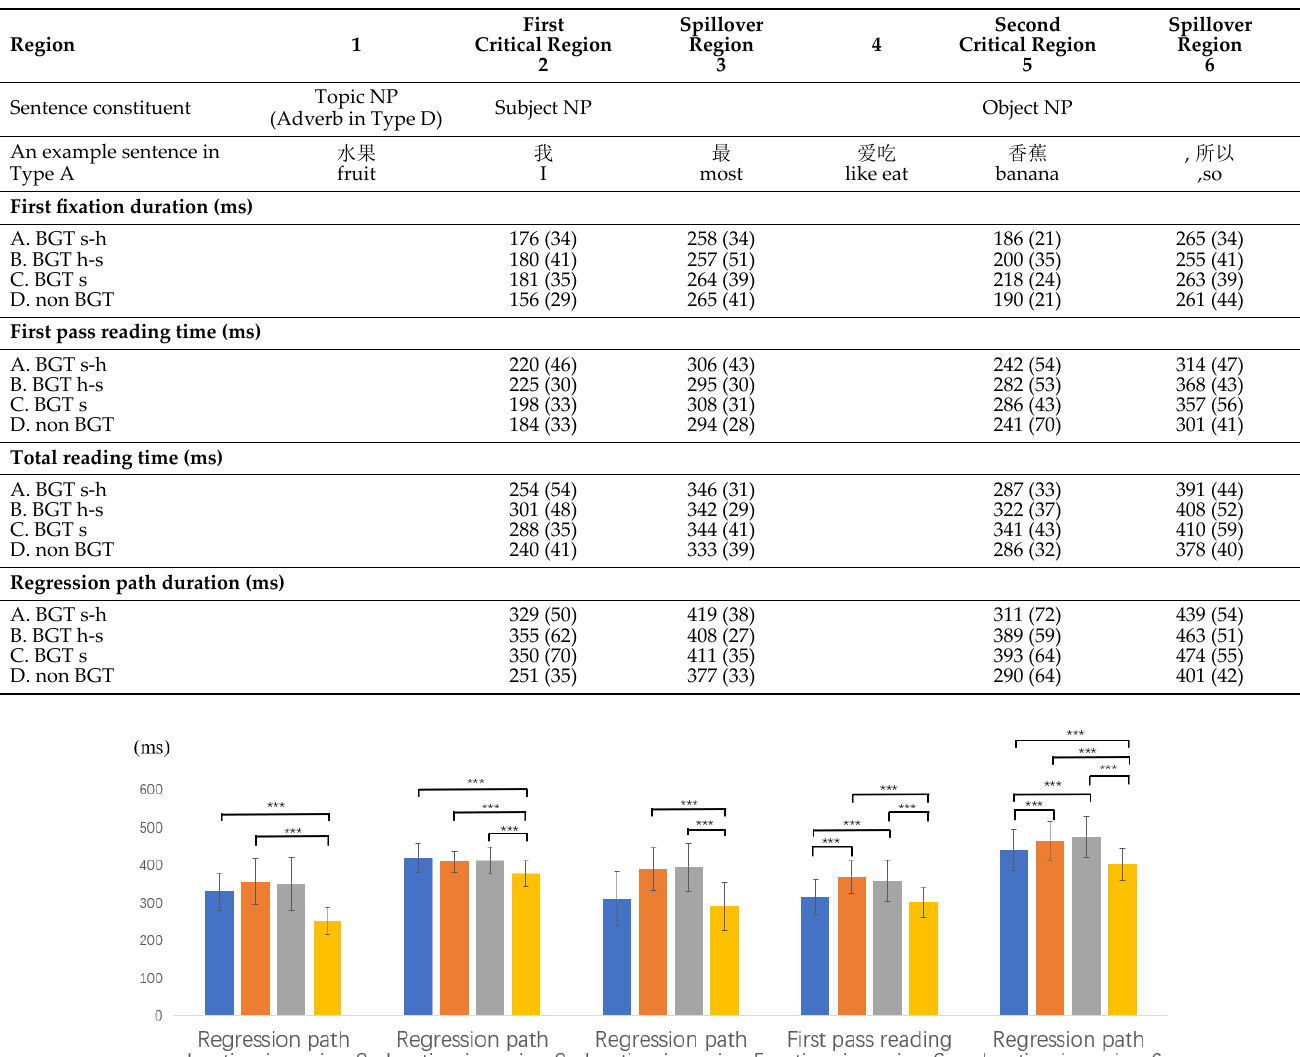
Table 5. Means (SD) of reading measures for advanced L2 learners.